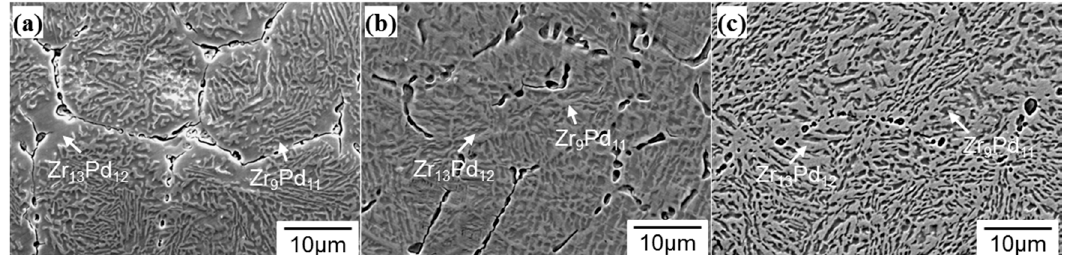
Figure 6. ( a – c ) SEM images of Zr-49, 50, and 51 atom % Pd alloys aged at 973 K for 3.6 ks, respectively. All the specimens consist of the Zr 13 Pd 12 and Zr 9 Pd 11 compounds.